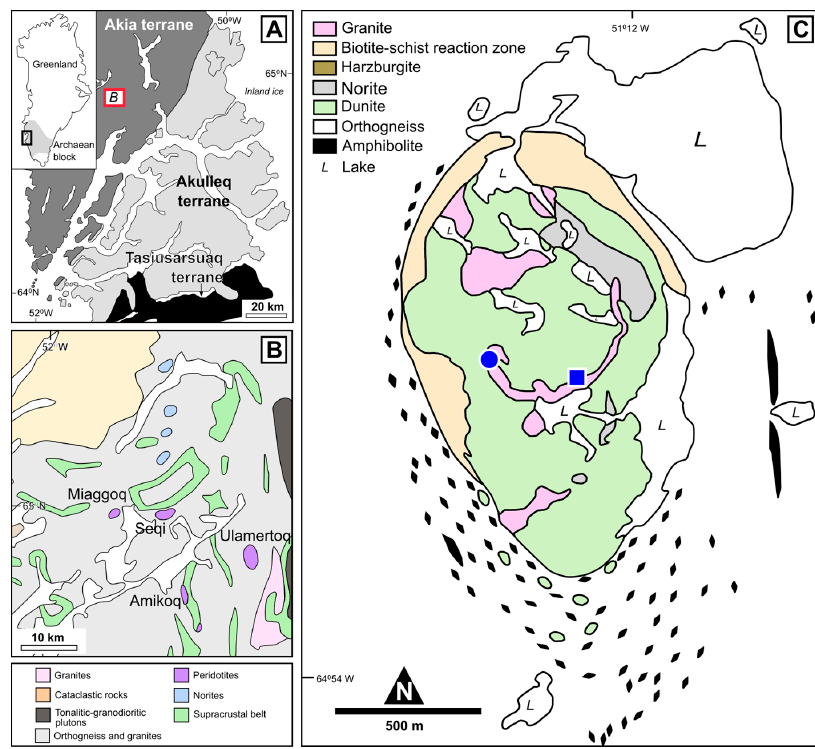
Figure 1. ( A ) Simplified geotectonic map of southern West Greenland showing the Akia, Akulleq, and Tarsiusarsuaq terranes; ( B ) Ultramafic bodies within the Mesoarchaean orthogneiss in Akia terrane (map modified from Geological Survey of Denmark and Greenland (GEUS) and Szilas et al. [22]); ( C ) Geologic map of Ulamertoq peridotite body showing the sampling locations of chromitites with zoned chromites (filled circle) and homogeneous chromites (filled square) (adapted from Garde [21]). The Ulamertoq peridotite body measures about 1 km × 1.5 km. The imm ediately surrounding orthogneiss host also includes smaller pods of amphibolite, as well as peridotite (Figure 1C). The Ulamertoq peridotite body is dominated by olivine-rich plutonic rocks containing orthopyroxene